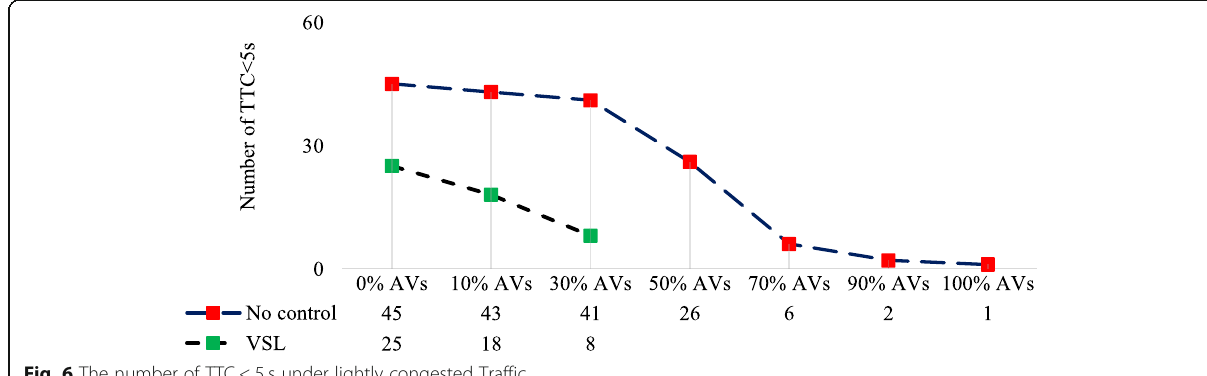
Fig. 6 The number of TTC< 5 s under lightly congested